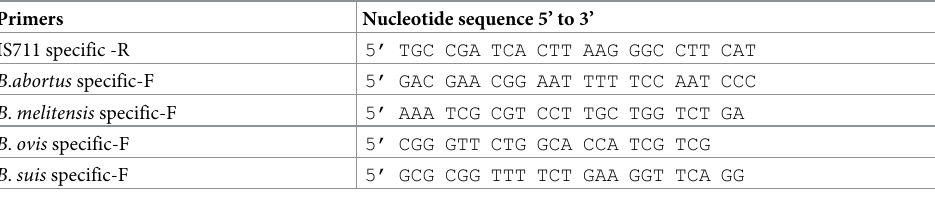
Table 1. Polymerase chain reactions primer